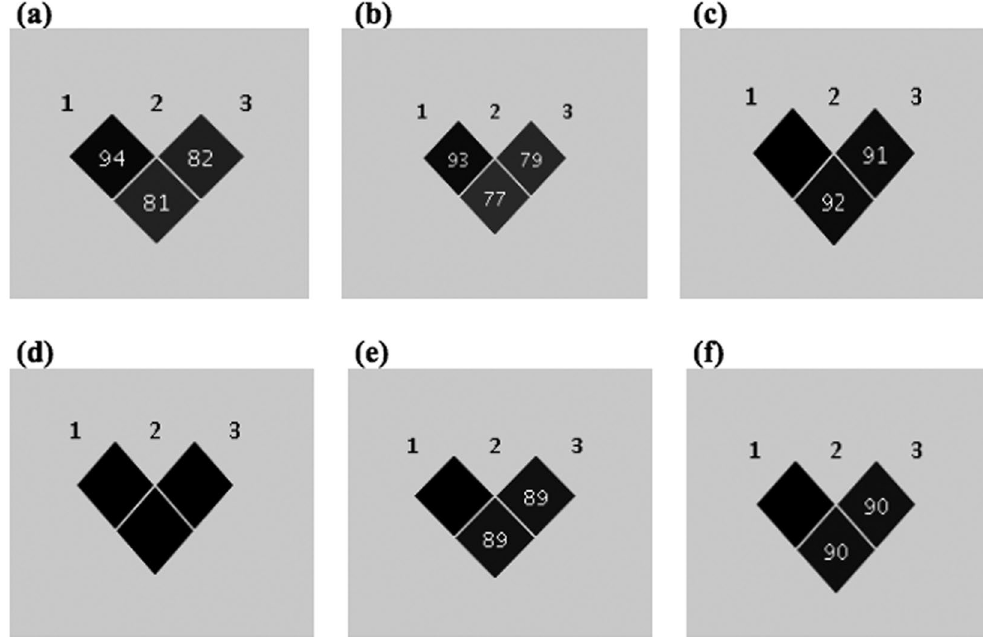
Figure 2. Dissecting LD among top PLA2R1 SNPs. 1 = intronic (rs4664308), 2 = 5 ′ UTR SNP (rs3749119), 3 = exon 5 missense SNP (rs35771982). LD (r 2 ) values in ( a ) all case-control combined data ( b ) all control samples ( c ) all IMN case samples ( d ) 50 IMN samples from the University of Tokyo Hospital ( e ) 42 IMN samples from Akita University and ( f ) 130 IMN samples from the BioBank Japan.